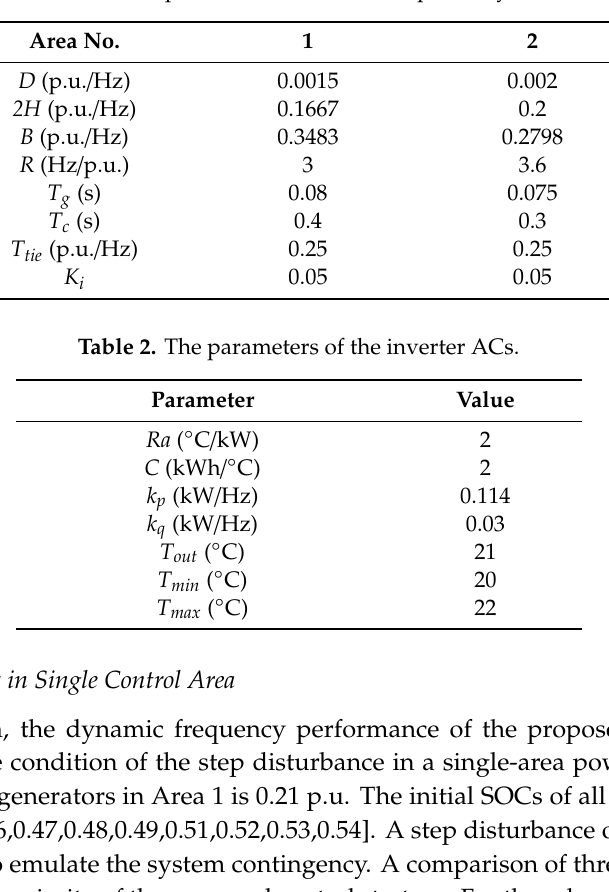
Table 1. The parameters of a two-area power system.